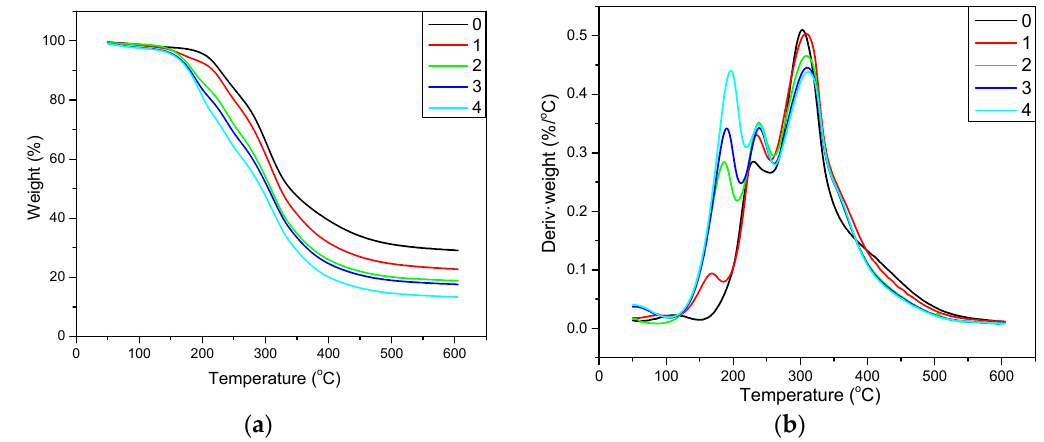
Figure 5. The ( a ) thermogravimetric (TG) and ( b ) derivative thermogravimetric (DTG) curves of the different adhesives: 0 (SM adhesive), 1 (SM/DRE-2 adhesive), 2 (SM/DRE-4 adhesive), 3 (SM/DRE-6 adhesive), 4 (SM/DRE-8 adhesive).